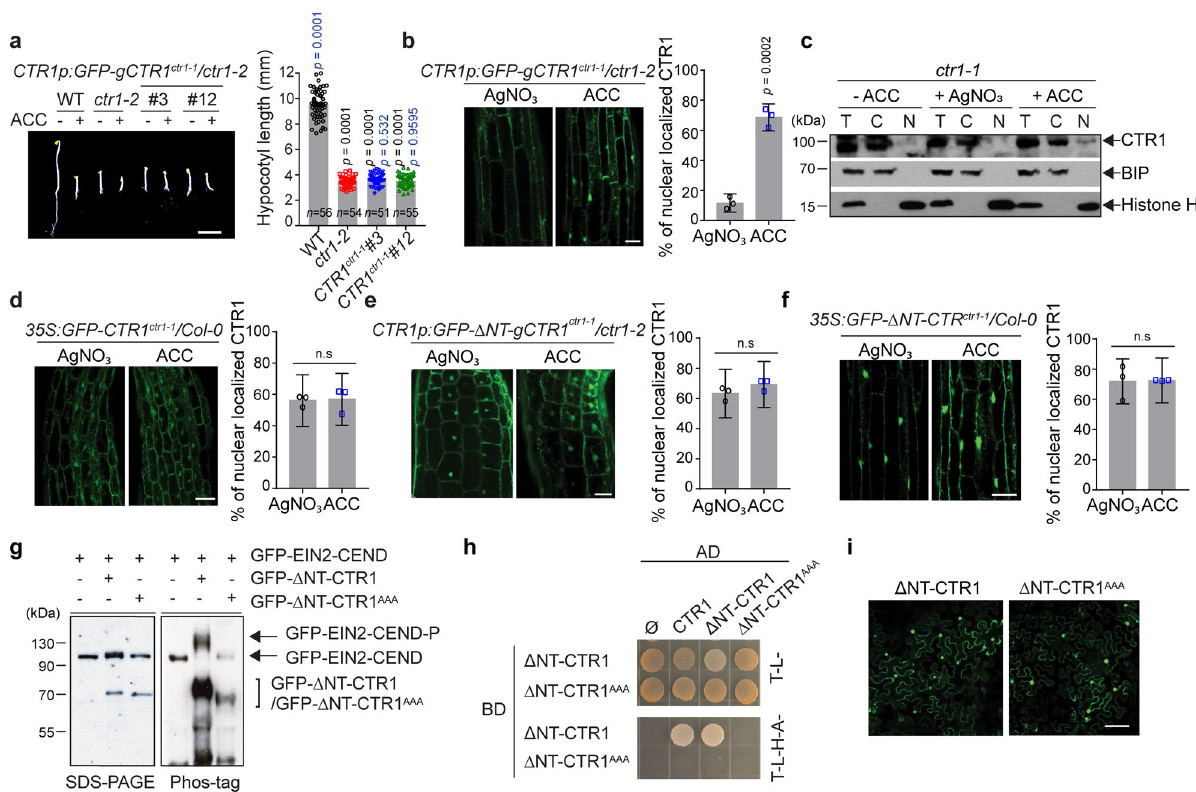
Fig. 3 | The kinase activity of CTR1 is not necessary for ACC-induced CTR1 nuclear translocation. a Seedlings were grown on MS medium with or without 10 μ M ACC for 3 d and photographed. Scale bar, 5mm. The graph represents the quanti fi cation of hypocotyl lengths of seedlings grown on MS without ACC. Sig- ni fi cancewasdeterminedbyone-wayANOVAwithDunnett ’ smultiplecomparisons test to compare the results to the WT (black) and ctr1-2 (blue) controls. Data represent the means and SE. b Seedlings expressing GFP-CTR1-1 from its native promoterweregrownonMSmediumwithorwithoutAgNO 3 .Thegraphrepresents the ratio of nuclear-localized CTR1 in dark-grown seedlings treated with ACC or AgNO 3 . Error bars, SE ( n =3 seedlings). c , Fractionation analysis of ctr1-1 mutant seedlingstreatedwithorwithoutACCandsilvernitrate. d OverexpressionofCTR1- 1 from 35S promoter leads to nuclear localization of CTR1 in the presence of silver nitrateandACC.Errorbars,SE( n =3seedlings). e , f SeedlingsexpressingGFP- Δ